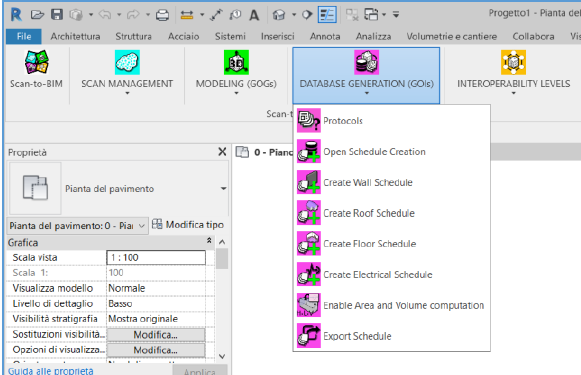
Figure 10. The third section allows users (expert and non- experts) to extract information from the HBIM model.